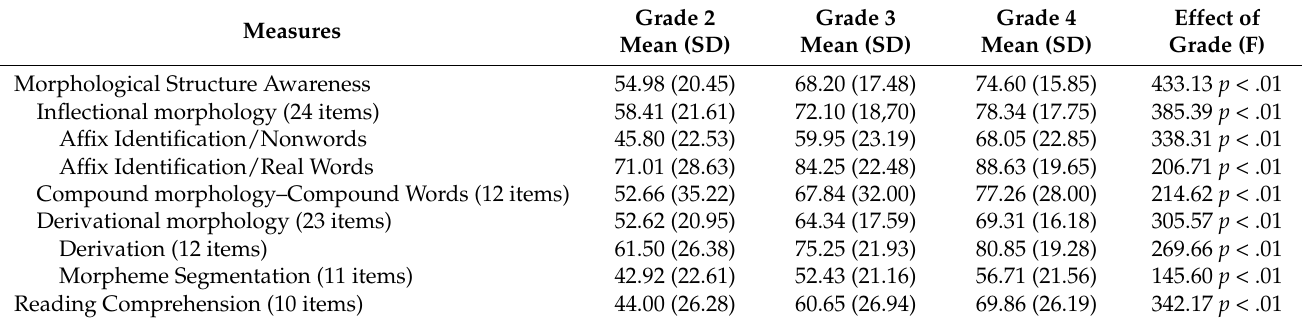
Table 6. Means and standard deviations in grades 2–4.